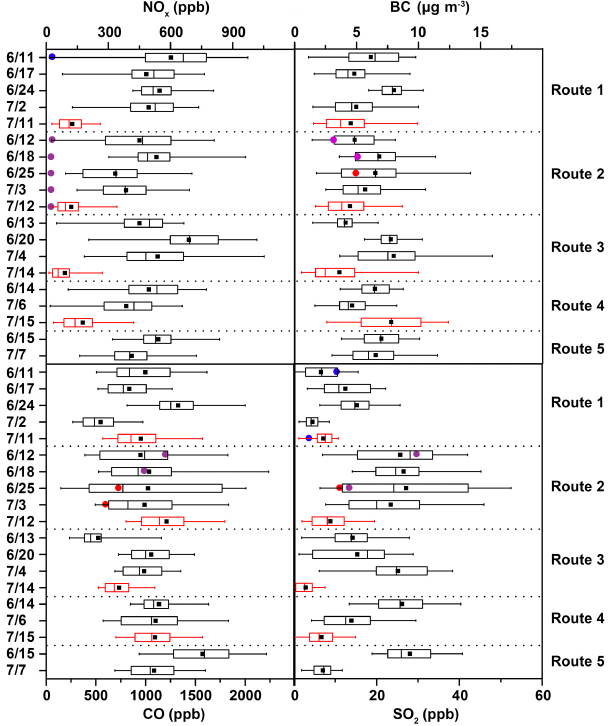
Figure 2. The concentrations of SO 2 , CO, BC and NO x in each trip in different routes. The red boxes were the results in the last experiment. Values marked were the 5th and 95th percentile (–), standard deviation (lower and upper box lines), median (middle box line) and mean ( (cid:4) ). The blue dots were results from the GC station. The purple dots were results of QZ station. The red dots were results from the YC